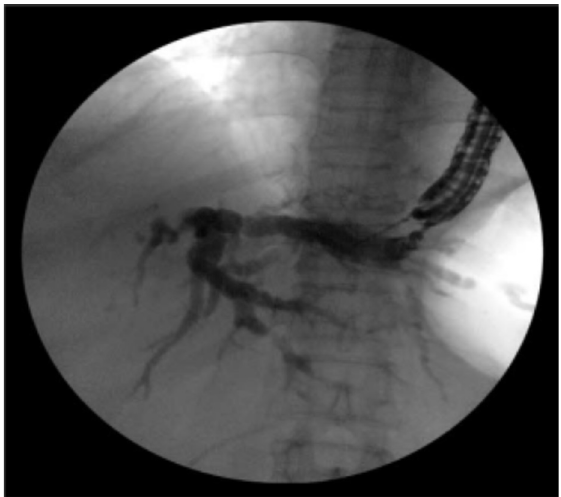
Figure 2. Location con fi rmed by cholangiography.